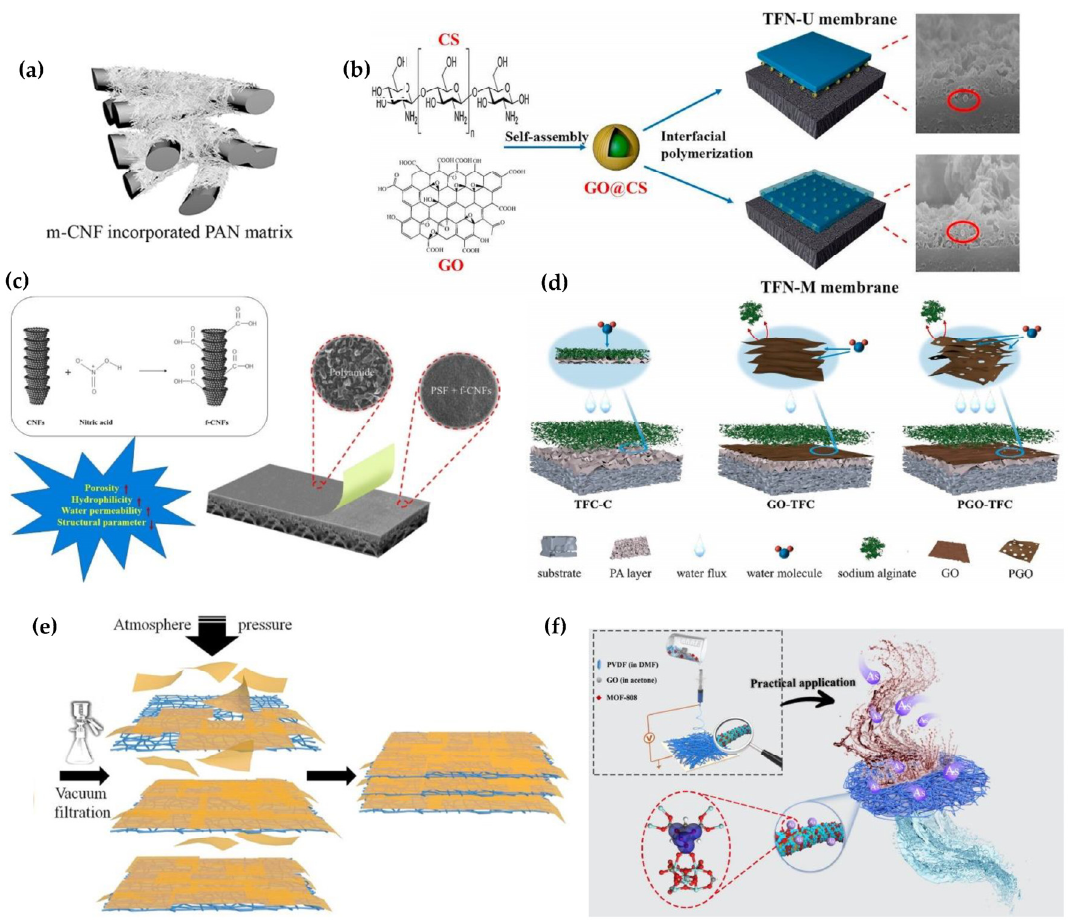
Figure 13. Various approaches of fabricating polymers and nanomaterials into membranes for water treatment applications: ( a ) cysteine-grafted cellulose nanofibers impregnated in electrospun polyacrylonitrile scaffold (microfiltration) [384] , © Elsevier, 2014; ( b ) Graphene oxide (GO)-coated chitosan nanoparticles incorporated into (TFN-M) or at the bottom (TFN-U) of polyamide (PA) layer during interfacial polymerization process (ultrafiltration) [64] , © Elsevier, 2021; ( c ) carboxylated carbon nanofibers embedded into polysulfone layer via phase inversion process with PA layer on top (forward osmosis) [385] , © Elsevier, 2020; ( d ) GO coated on PA layer via layer-by-layer technique [386] , © Elsevier, 2022; ( e ) Vacuum filtration of bacterial cellulose and GO dispersion [70] , © Scientific Reports, 2016; ( f ) Membrane based on electrospun fibers of homogenous slurry of polyvinylidene difluoride and GO mixed with metal organic framework [67] , © Elsevier 2022.